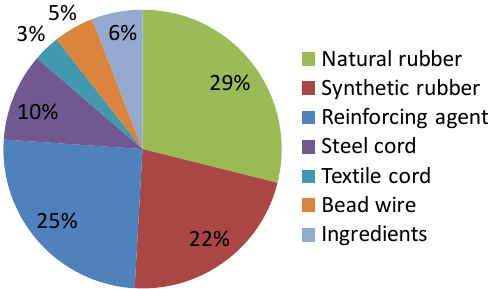
Figure 1. Composition of main materials used in automobile tires in Japan in 2012 [5].